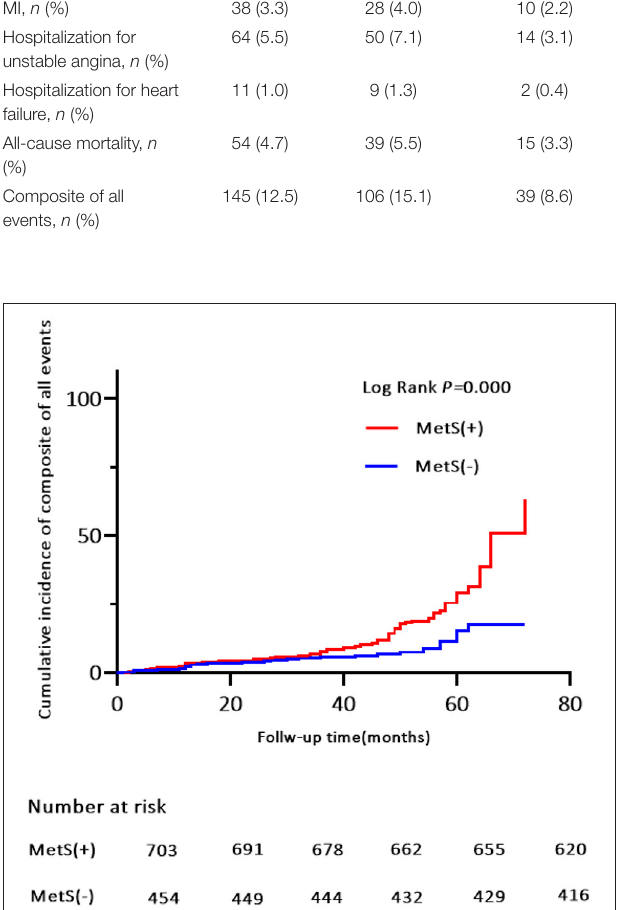
FIGURE 4 | Kaplan-Meier estimates of cumulative incidence (%) for composite of all events. Log-rank test, P = 0.000.